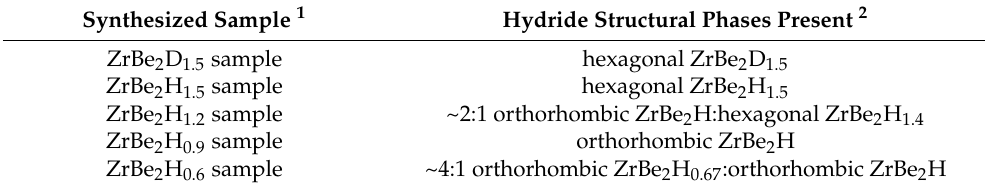
Table 1. Summary of the room-temperature phases present in the ZrBe 2 D x and ZrBe 2 H x samples. Synthesized Sample